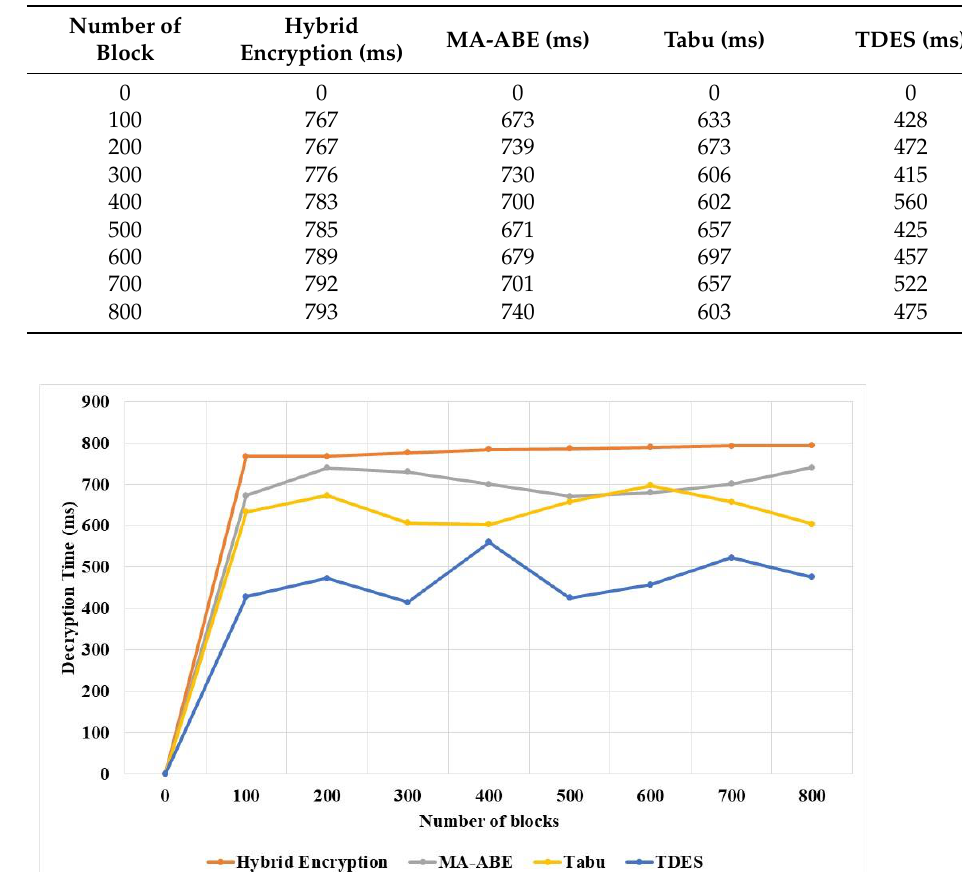
Figure 8. TDES and existing techniques decryption time for various number of blocks.